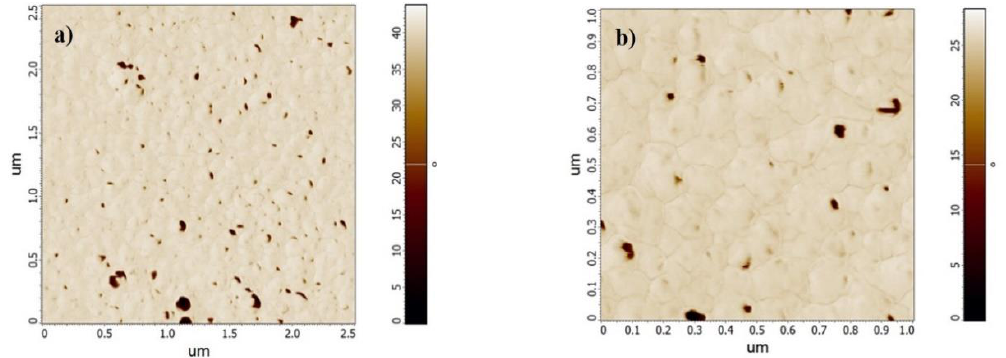
Figure 6. Phase maps for Pt deposited on a glass substrate for areas of ( a ) 2.5 × 2.5 µm and ( b ) 1 × 1 µm. In the case of PtTi, the average roughness was determined as being R a = 8.8 nm (Figure 7).